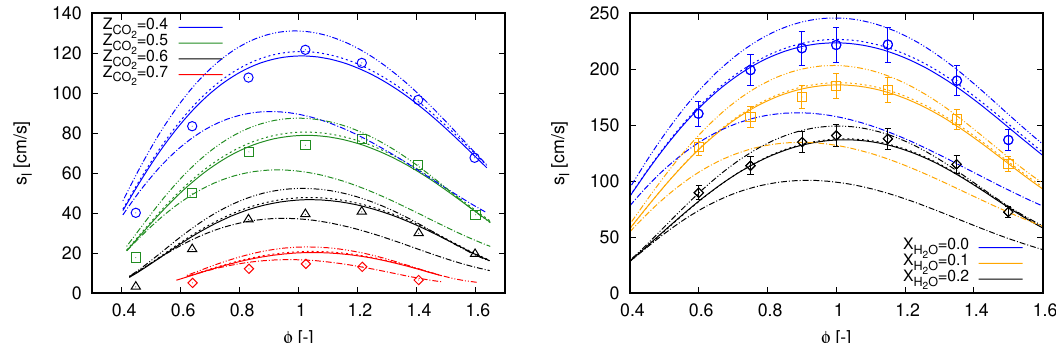
Figure 7. Laminar flame speed computed with different diffusion transport modeling strategies using freely propagating flame reactors. Marks, experimental data; continuous lines, complex; dashed lines, mixture-averaged without thermal diffusion modeling; dash-dot-dot lines, mixture-averaged with thermal diffusion modeling; dash-dot lines, unitary Lewis number. ( left ) CO 2 dilution with experimental data extracted from [3]; and ( right ) H 2 O dilution with experimental data extracted from